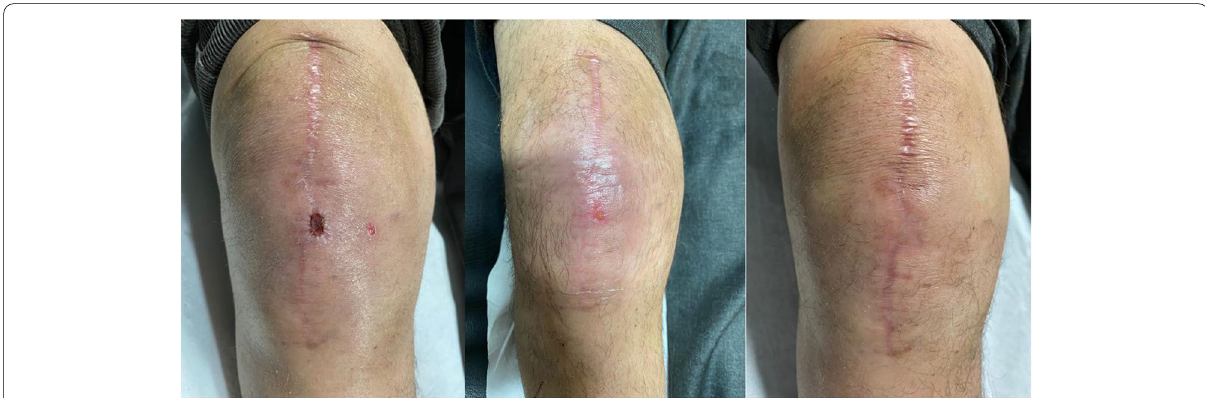
Fig. 2 The ulcer after the treatment. Four weeks after the treatment, the wound was partially healed (left). Six weeks after the treatment, the wound was complete closure (complete healing) (middle). The wound complete closure at one‑year follow‑up